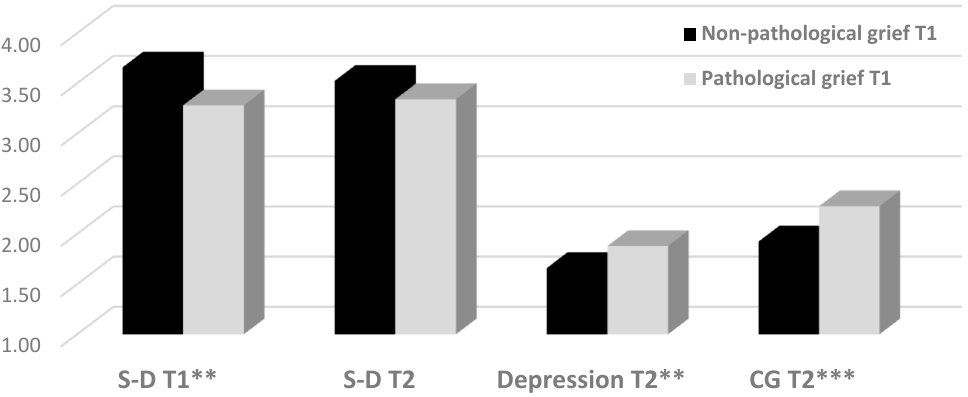
Figure 1. Differences between pathological and non-pathological CG in the study variables ( N = 156). S-D = self-disclosure; CG = complicated grief; ** p < 0.01; *** p < 0.001.